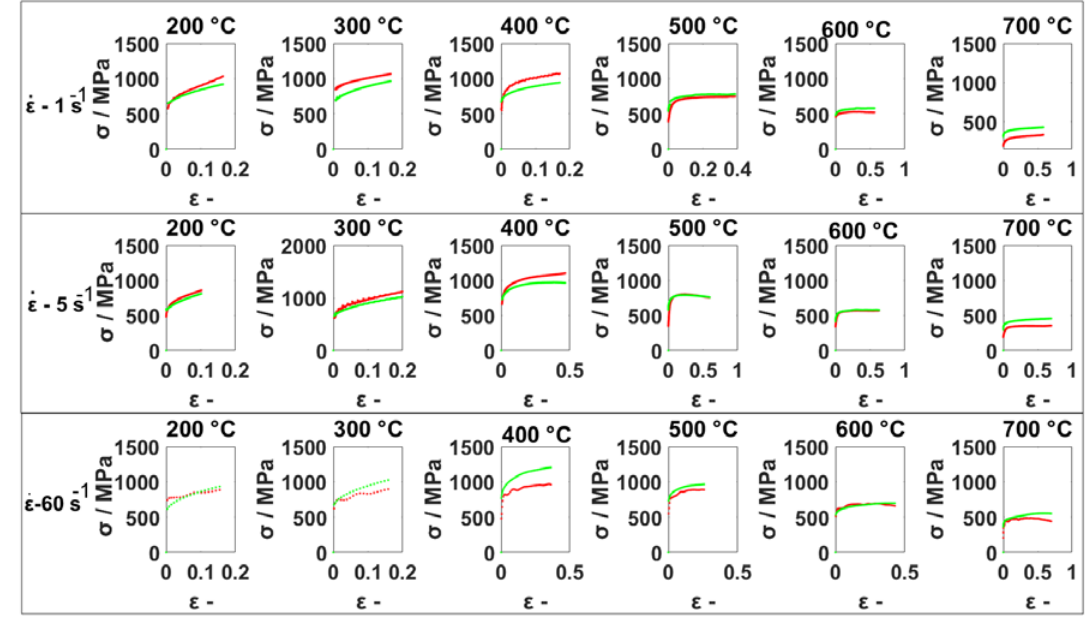
Figure 3. Flow stress curves predicted by the modified JC (MJC) model compared with the flow stress curves obtained using compression tests using Gleeble thermomechanical simulator at strain rates 1 s − 1 , 5 s − 1 and 60 s − 1 (Model: Green color; Experimental: Red color). MJC model predicted σ 0.1 at a 𝜀(cid:4662) of 0.52 × 10 4 s − 1 is plotted in Figure 4 to evaluate the validity of extending the hypothesis of DSA presence at very high strain rates. The model can predict σ 0.1 with reasonable accuracy. The flow stress at a strain of 0.1 is chosen to avoid the transient conditions during the early stages of loading in compression testing.